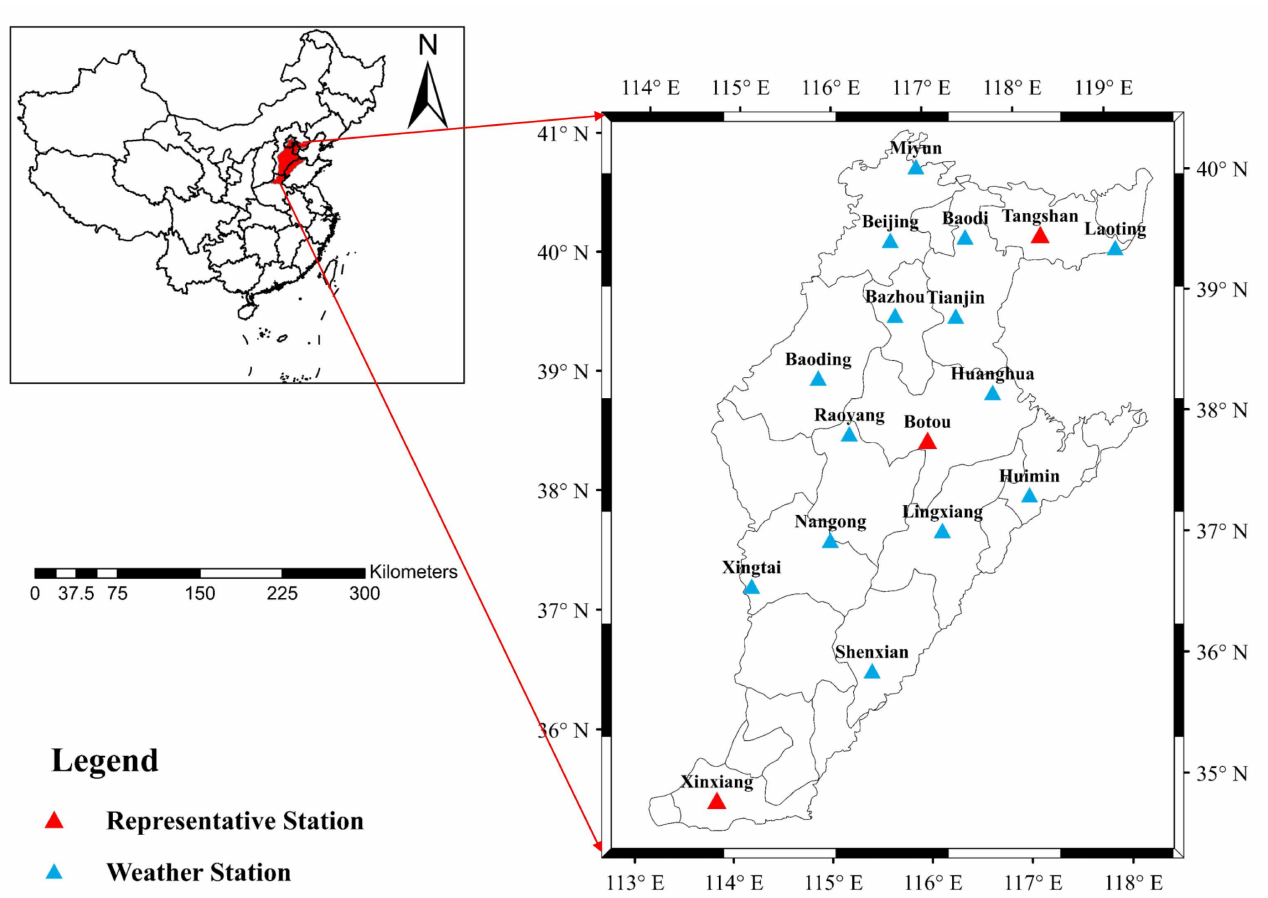
Figure 1. Location of the 17 weather stations used in this study. The red sites Xinxiang (XX), Botou (BT), and Tangshan (TS) are representative of the north–south and east–west geographic locations.